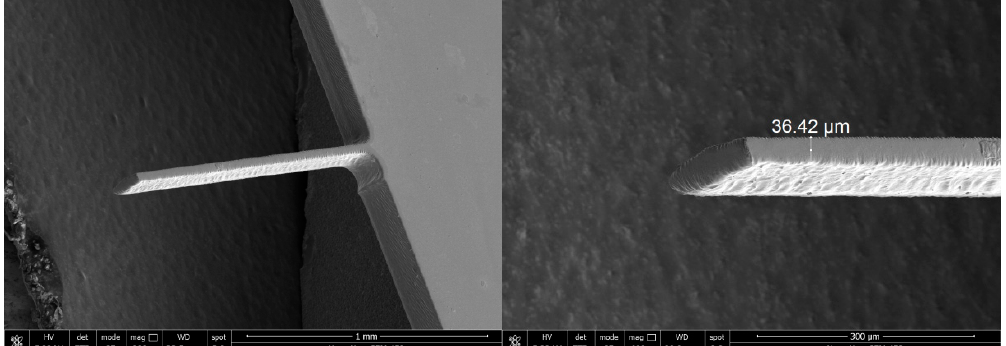
Figure 18. Micro cantilever beam on 35 μ m thick glass workpiece.